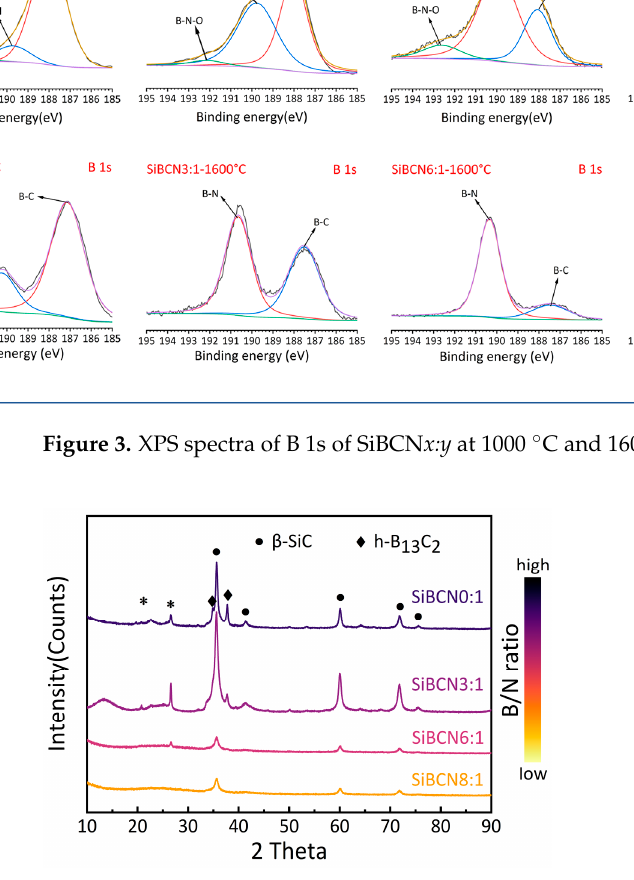
Figure 4. XRD spectra of SiBCN x:y annealed at 1600 °C in Ar gas (*: SiO 2 ).